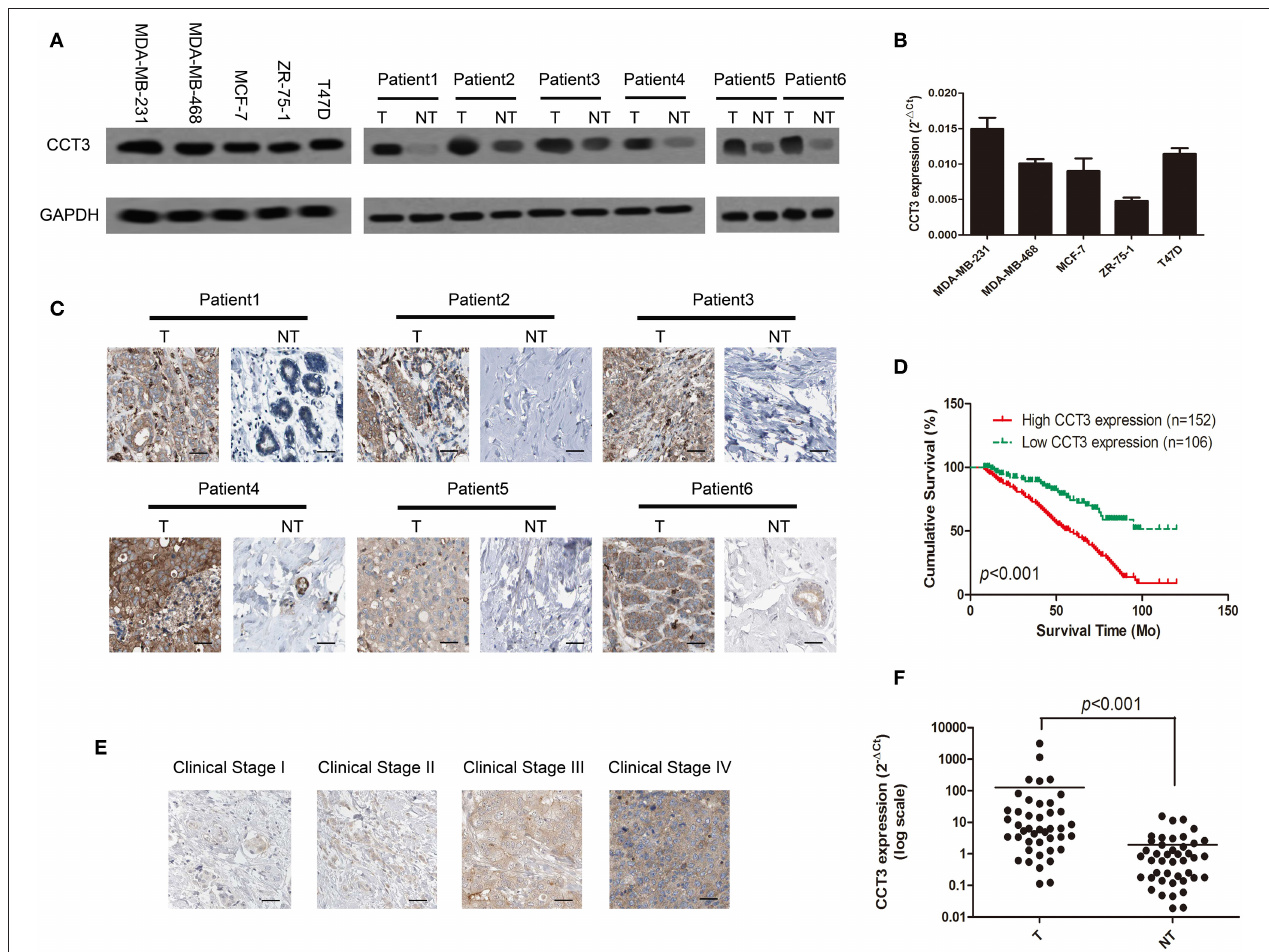
FIGURE 1 | CCT-3 is upregulated in breast cancer. (A) Protein levels of CCT-3 in five breast cancer cell lines (left) and in matched primary breast cancer tissues (T) and corresponding non-tumorous tissues (NT; right). (B) RNA levels of CCT-3 in five breast cancer cell lines. (C) Immunohistochemistry (IHC) staining analysis of CCT-3 protein expression in matched primary breast cancer tissues (T) and corresponding non-tumorous tissues (NT). (D) Kaplan–Meier curves with univariate analyses (log-rank) for patients with breast cancer with low CCT-3-expressing ( n = 152) vs. high CCT-3-expressing tumors ( n = 106). (E) IHC staining analysis of CCT-3 protein expression in breast cancer tissues from clinical stages I to IV. (F) Mann–Whitney test for CCT-3 expression in 43 pairs of breast cancer tissues (T) and their corresponding non-tumorous tissues (NT) (frozen